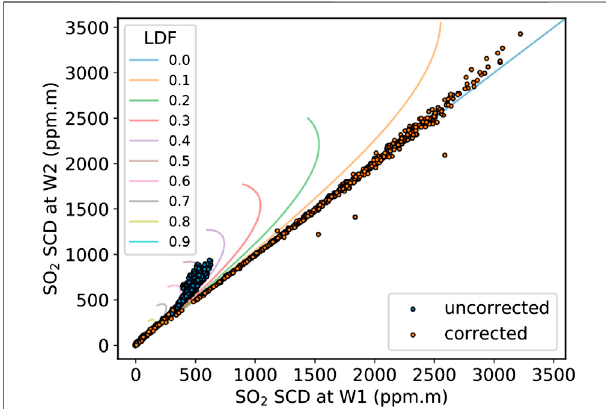
FIGURE 7| Correction oflight dilution in spectra captured from Mirador. The original spectra are analyzed using the W1 (306 – 316 nm) and W2 (312 – 322 nm) wavebands, retrieving SO 2 slant column density (blue dots). The light dilution modeled curves (colored lines for LDFs every 0.1) indicate an LDF of between 0.4 and 0.6 is occurring. We then reanalyze the spectra with the LDF determined from the lookup table at both wavebands